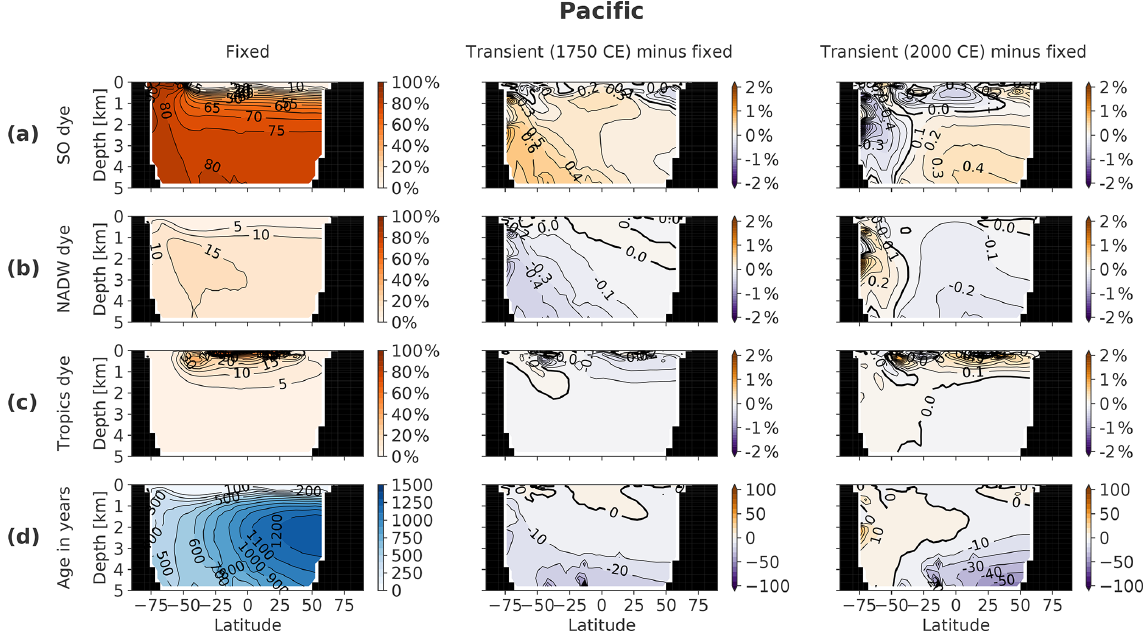
Figure 9. Zonally averaged meridional section of the Pacific basin, including the SO sector, showing (a) Southern Ocean dye tracer, (b) North Atlantic Deep Water dye tracer, (c) tropics dye tracer and (d) ideal age. Columns show the fixed-circulation simulation (OcFIX) and the anomaly of transient (OcTRA) compared to fixed dye tracer in 1750 (coldest time in LIA) and 2000CE. Units for dye are a fraction of initial dye concentration at the surface, in percent. Colour levels for Pacific anomalies increase in steps of 0.1% dye or 10 years of